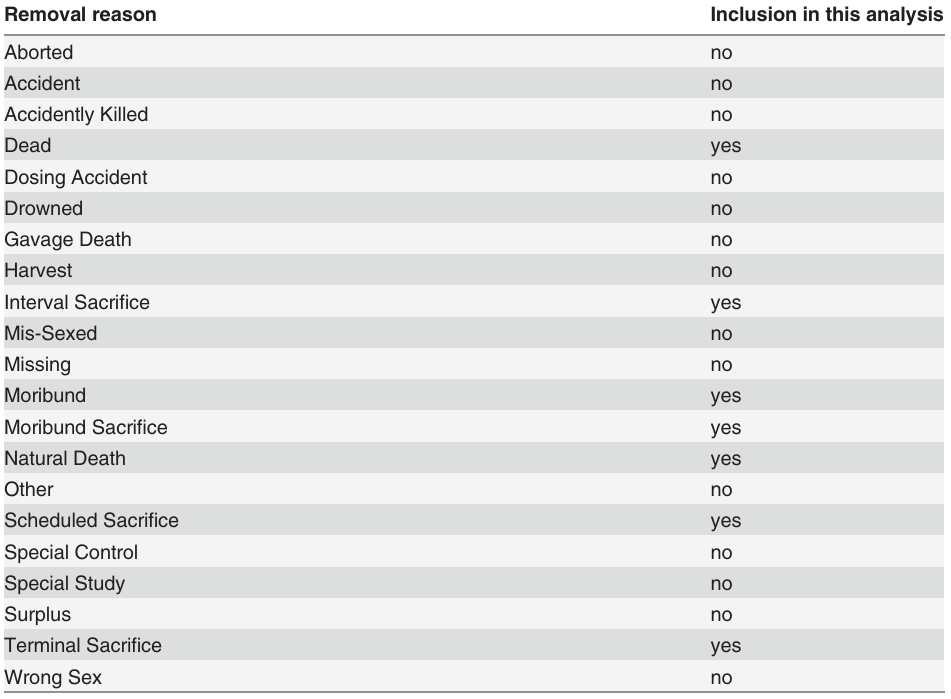
Table 5. Reasons for removal of an animal from a 2Y-CS. Removal reason Inclusion in this analysis Aborted no Accident Accidently Killed